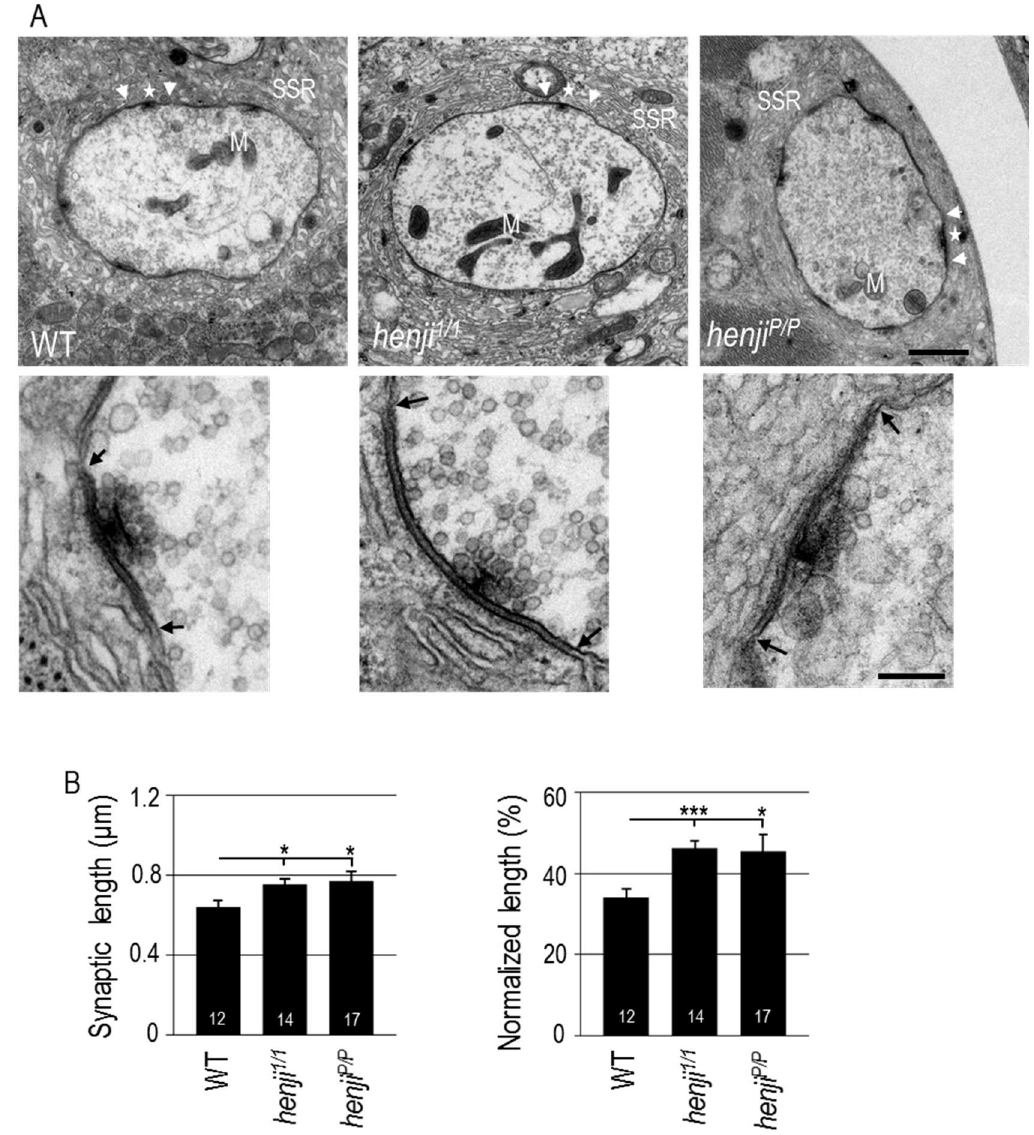
Fig 4. Ultrastructures of enlarged synaptic regions at henji NMJs. (A) Electron micrographs show NMJ boutons of WT, henji 1/1 and henji P/P with synaptic regionsmarked by two arrowheads. T-bars are indicatedby stars and mitochondria by M. Enlargedimages of synaptic regions within two arrows were shown in bottom panels. Scale bar is 1 μ m in the upper panel and 0.2 μ m in the lower panel. (B) Synaptic area are expandedin henji mutants, with absolute length of dense membrane WT, 0.64 ± 0.03; henji 1/1 , 0.75 ± 0.03; henji P/P , 0.77 ± 0.05 ( μ m), and normalized length (to bouton perimeters) in WT, 34.00 ± 2.14; henji 1/1 , 46.15 ± 1.91; henji P/P , 45.57 ± 4.08 (%). Statistical significance by unpairedStudent t-test is shown as * for p < 0.05; ** for p < 0.01; *** for p <